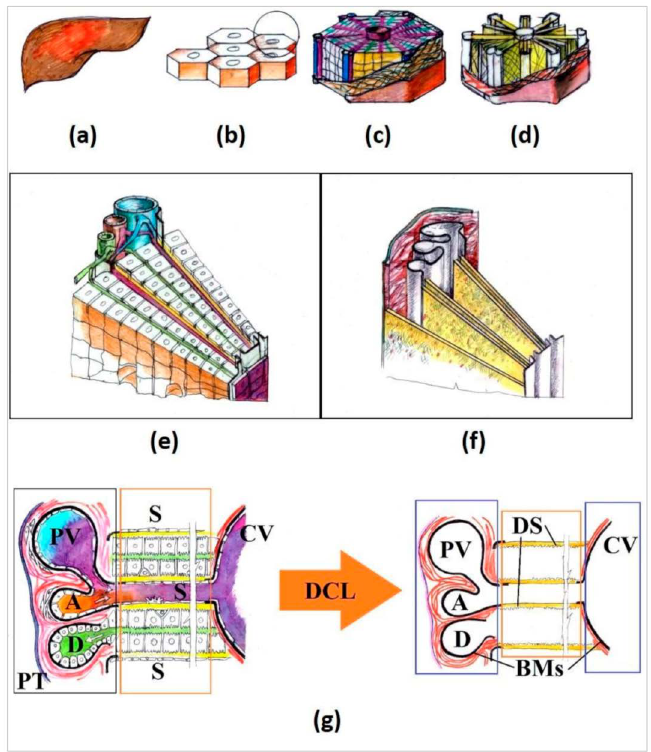
Figure A4. Schematics of the liver structure and the effect of DCL on its constituents. The liver ( a ) is formed by lobules ( b ). Each lobule ( c ) has a central vein in the middle and radially arranged cords of hepatocytes separated by sinusoids (radial purple lines) and bile canaliculi (radial green lines). The border of each lobule consists of loose connective tissue sheaths (red coating), which contain portal triads and interlobular vasculature branches in the corners of each lobule’s “hexagon.” As a result of DCL ( d ), all of the cellular elements are removed. ( e ) Detailed view of the sector of a single lobule. Each cord of hepatocytes contains two rows of the polarized cells. One side of the cell row is in contact with a sinusoid blood vessel (purple) through the space of Disse (yellow), while the other side of the cell row is in contact with a bile canaliculus (green) directly. Cells of the sinusoids and other cells of parenchyma, except hepatocytes, are not shown for simplicity. Blood from the portal vein (large blue blood vessel) and hepatic artery (smaller red blood vessel) is mixed in the sinusoids and transported through the liver parenchyma toward the central vein in the middle of the lobule. Bile is transported to the portal bile duct in the opposite direction. Portal vein, artery, and bile duct make a portal triad. ( f ) 3D view of the effect of DCL on the sector of a single lobule, shown at ( e ). Note the absence of cellular elements and preservation of collagenous stroma of interlobular septae and connective tissue sheaths of large blood vessels (red), basement membranes of large blood vessels and portal bile ducts (grey), and the ECM of Disse’s space (yellow). ( g ) 2D detailed schematic view of a segment of a lobule before (left) and after (right) DCL and segmentation of the parenchymal and stromal compartments. Note a portal triad (PT), containing a portal vein (PV), a hepatic artery (A), and an interlobular bile duct (D); sinusoids (S) with discontinuous endothelial lining separated from hepatocytes by Disse’s space (yellow). Narrow bile canaliculi (green) are visible between the rows of hepatocytes inside the cords. Bile canaliculi do not have their own cell linings. The central vein (CV) has the entire endothelial lining, basement membrane (BM), and collagenous sheath (red lines) around it. The structure of portal blood vessels is similar to that of the CV, but the layer of smooth muscle cells is thicker (it exists only before DCL). Red color indicates fibrous collagen. Black lines indicate basement membranes (BMs). Parenchymal compartment is shown by orange boxes, and the stromal one is indicated by blue